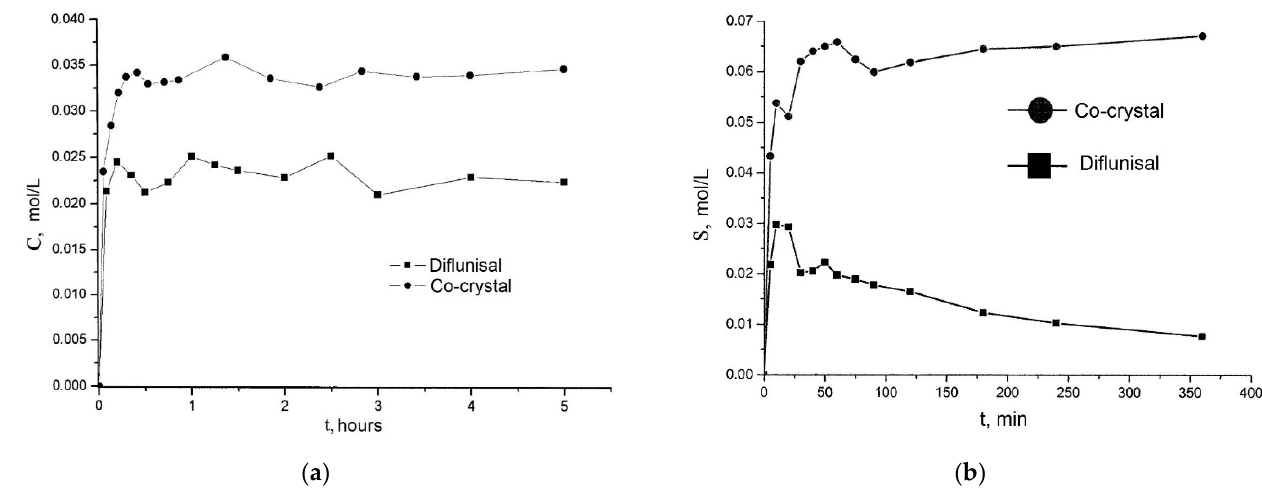
Figure 16. The release profiles of ( a ) native diflunisal ( ◼ ) and from diflunisal–theophylline co-crystal ( ● ); ( b ) native diflunisal ( ◼ ) and from diflunisal–isoniazid co-crystal. Adapted from [60,61], 2021.